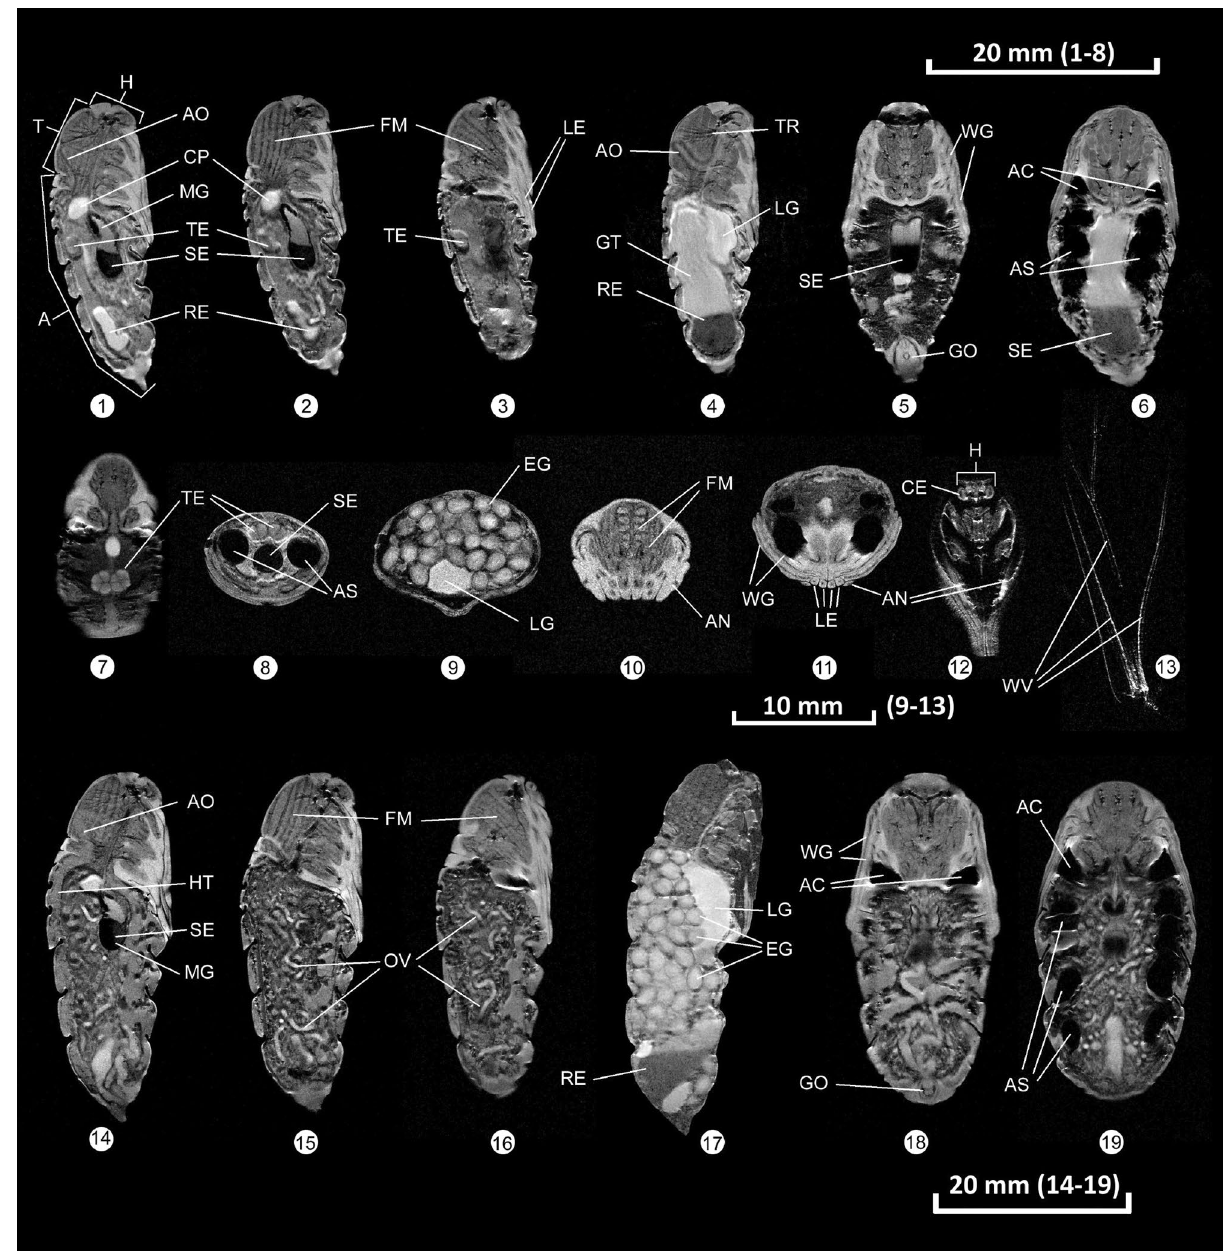
Figure 1. Morphological features of pupal development in Saturnia pavonia . First row (1–6): Male pupae at different developmental stages (1–4: sagittal view, 5 and 6: coronal view). Second row (7–13): Selected, slightly enlarged views of interest from males and females (7 and 12: coronal view, 8–11 axial view, 13: fully developed wing of an imago immediately after eclosion). Third row (14–19): Female pupae at different developmental stages (14–17: sagittal view, 18 and 19: coronal view). A abdomen, AO aorta, AC air cavity, AN antenna, AS air sacs, CE compound eye, CP crop, EG egg, FM flight muscle (dorsoventral and dorsolateral), GO genital opening, GT gut, H head, HT heart tube, LE leg, LG labial gland, MG midgut (filled with aqueous liquid (bright) and a sediment (dark)), OV ovaries, RE rectum, SE sediment, T thorax, TE testicle, TR trachea, WG wing and wing sheaths, WV wing while columns 2 and 3 depict medial slices in coronal view without (column 2) and with (column 3) fat suppres- sion—thus, areas that occur darker in column 3 vs. 2 exhibit significant amounts of fat depots (triglycerides). Axial views of head and thorax as well as abdomen are given in columns 4 + 5, respectively. As a kind of baseline controls, the upper two rows show an over-lying pupa which did not hatch after the first winter (first row) and a diapause pupa before the first winter (second row), which successfully eclosed thereafter. In the following rows, examples of the development of pupae are illustrated from day 6 to 1 (male) or day 7 to 1 (female) before eclosion with the final images of the imagoes in the last row.